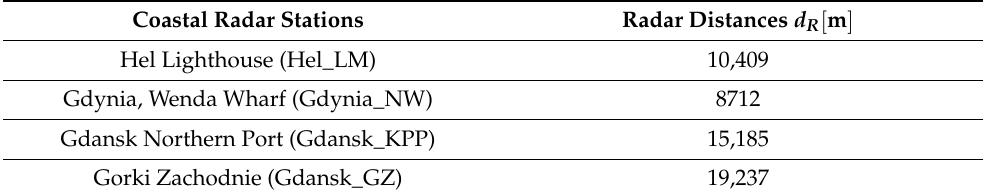
Table 2. Measured distances from coastal radar stations.